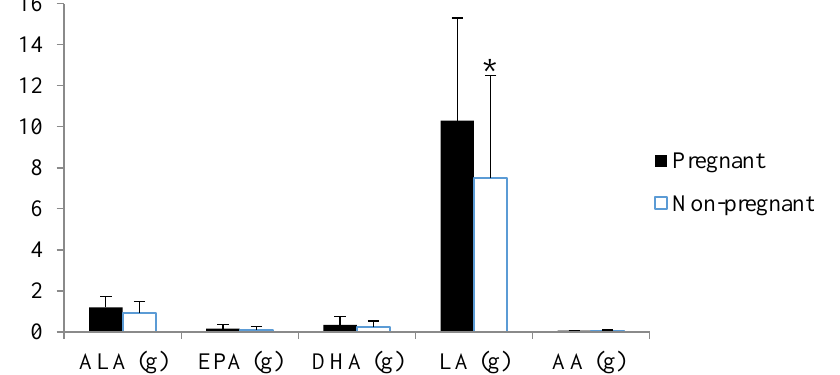
Figure 1. Pre-study polyunsaturated fatty acid intake over the prior 12 months for women who did and did not become pregnant during the intervention. Data were analysed by logistic regression adjusted for smoking and BMI status and are presented as mean ± SD. * Significant difference ( p = 0.045) for LA between women who did and did not become pregnant. AA: arachidonic acid, ALA: Alpha-linoleic acid, DHA: docosahexaenoic acid, EPA: eicosapentaenoic acid, LA: linoleic acid.